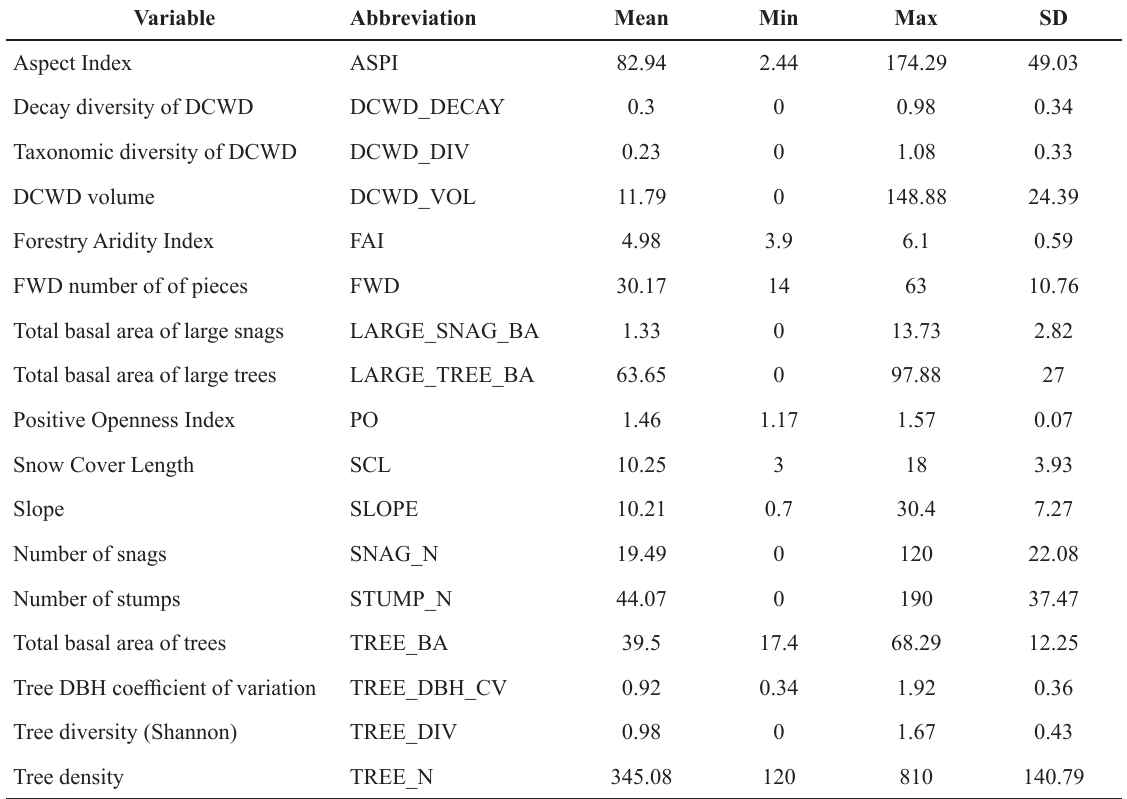
Table 1 – Descriptive statistics of environmental and forest stand variables used in the analysis of lignicolous fungal assemblages in the North-East Region of